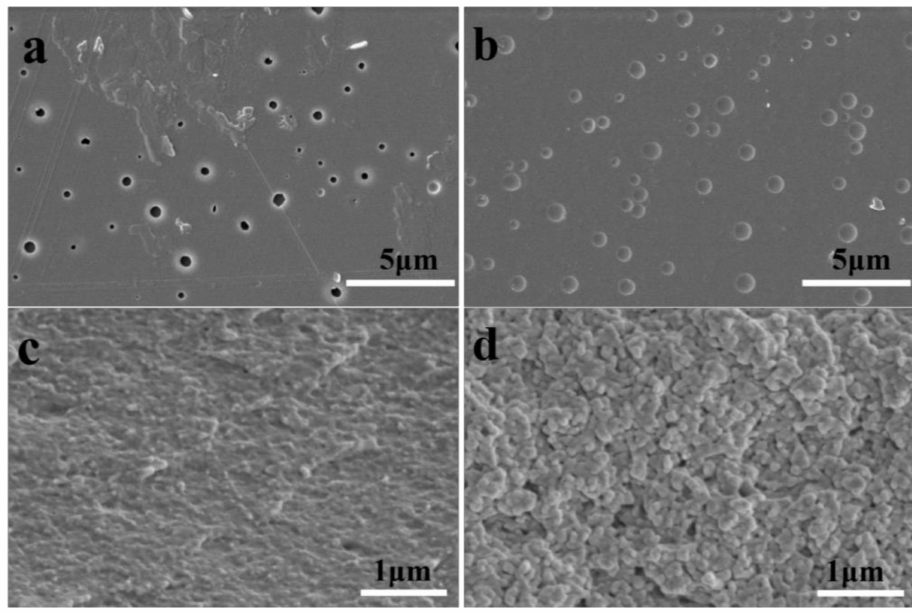
Figure 4. Scanning electron micrographs of CA film and CA-Eu light conversion film. ( a ) the surface of CA film, ( b ) the surface of CA-Eu film, ( c ) the section of CA film, ( d ) the section of CA-Eu